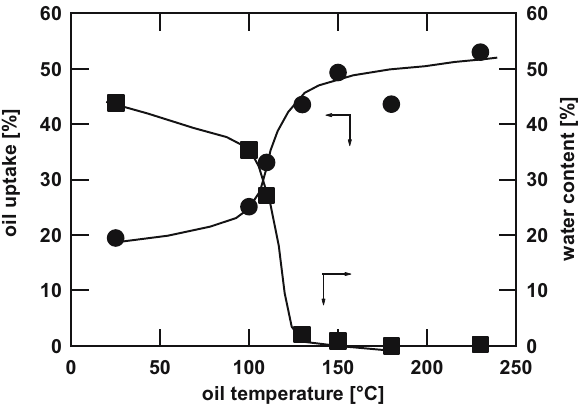
Figure 7: Changes in the oil uptake and water content for wet co ff ee grounds with the oil